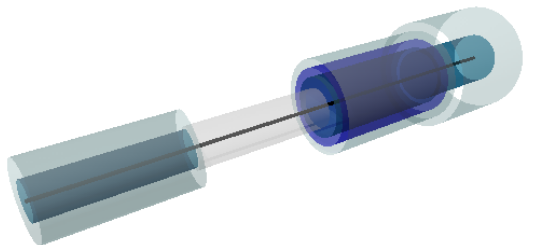
Figure 5: A Free Shape Context. Gray cylinder near middle is inactive - it will not contribute to the shape